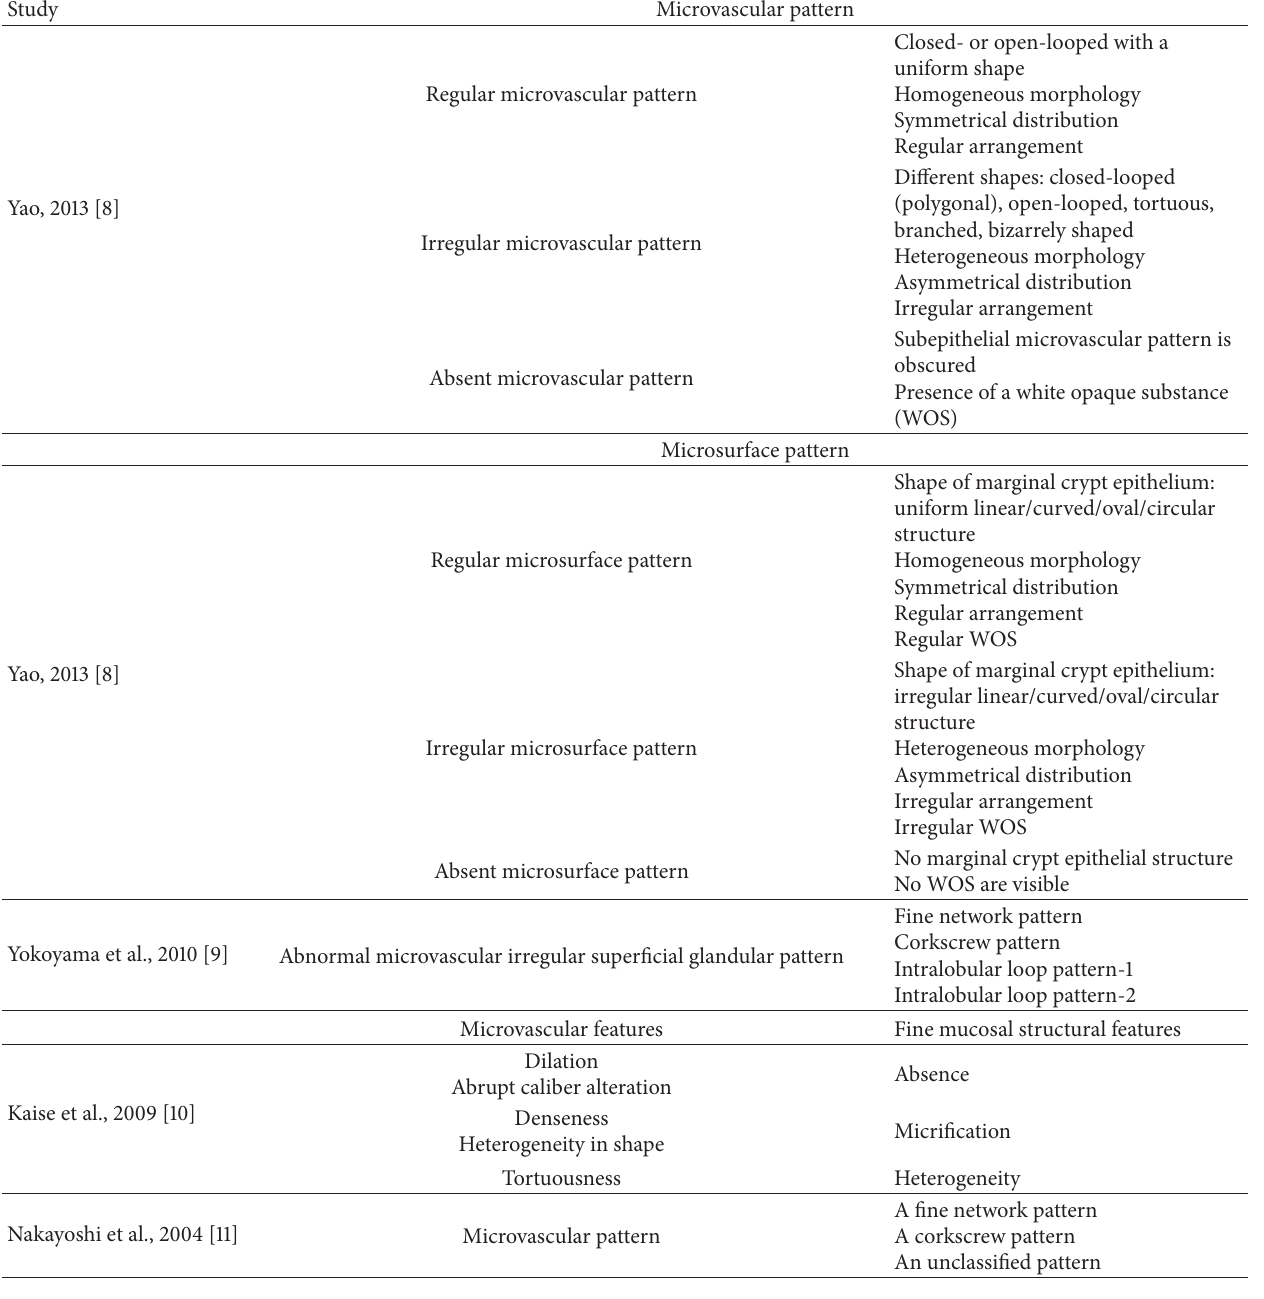
Table 1: Microvascular/microsurface